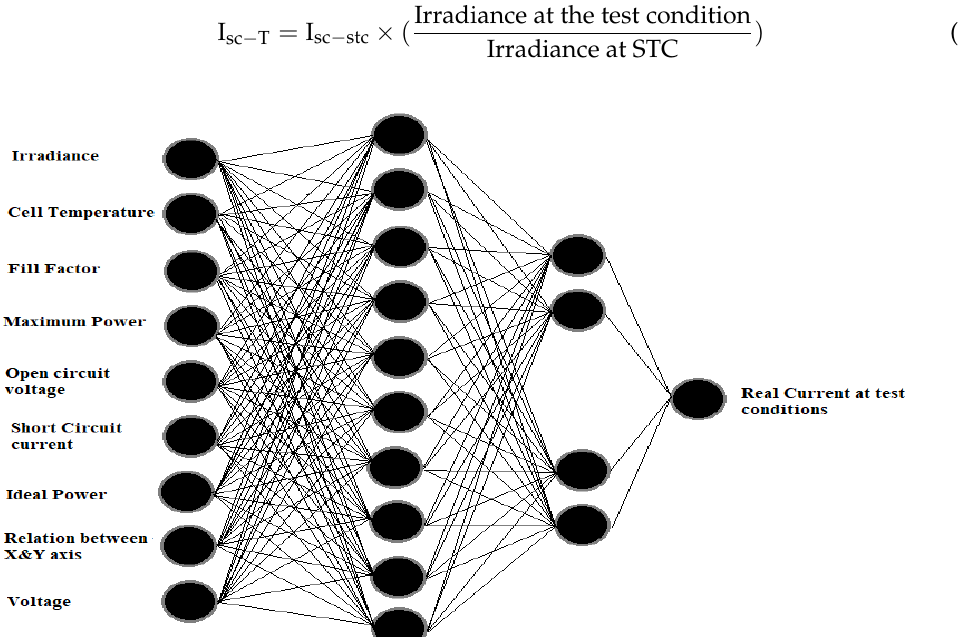
Figure 5. The second proposed GRNN flowchart to predict the real current.